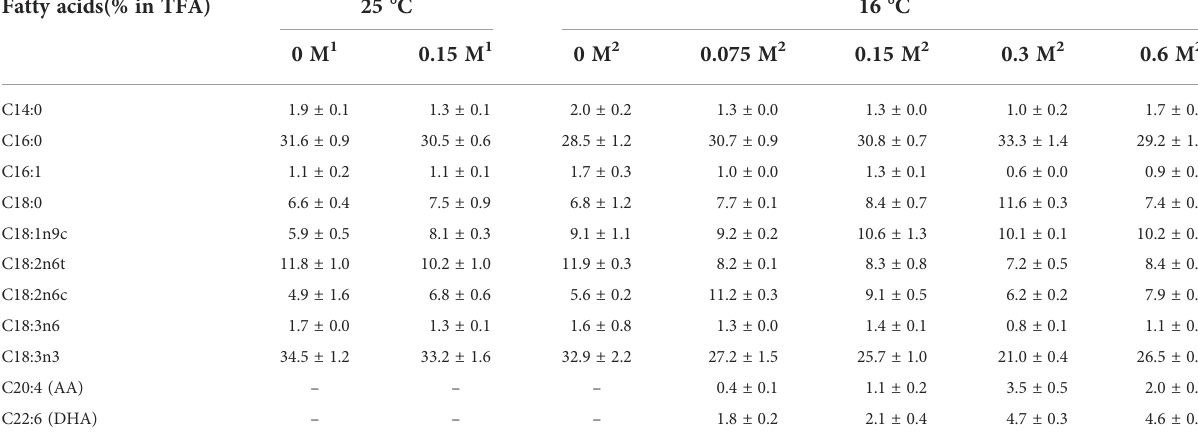
TABLE 1 Fatty acids pro fi le of HTBS cells under various conditions. Fatty acids(% in